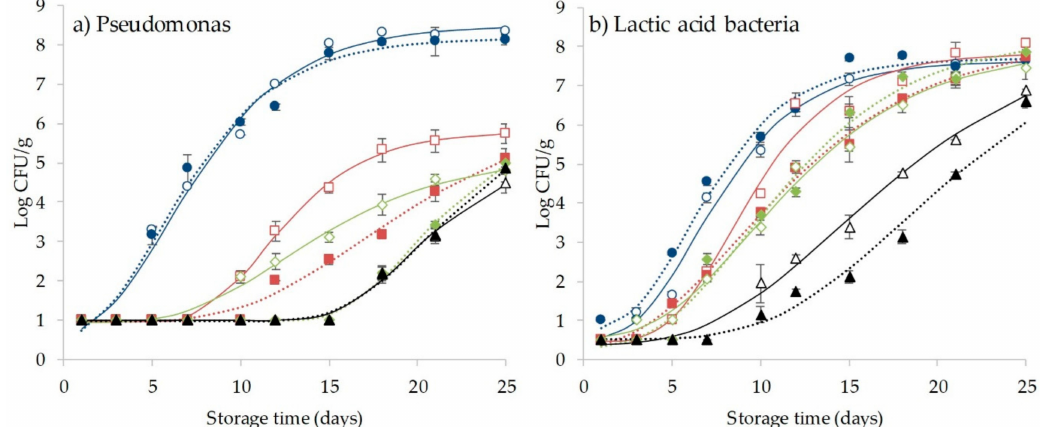
Figure 2. Growth curve of ( a ) Pseudomonas and ( b ) lactic acid bacteria (LAB) in treated and untreated coho salmon fillets. Symbols and lines (solid—without high hydrostatic pressure (HHP); dashed—with HHP) represent observed and modeled (re-parameterized version of Gompertz equation) values, respectively.